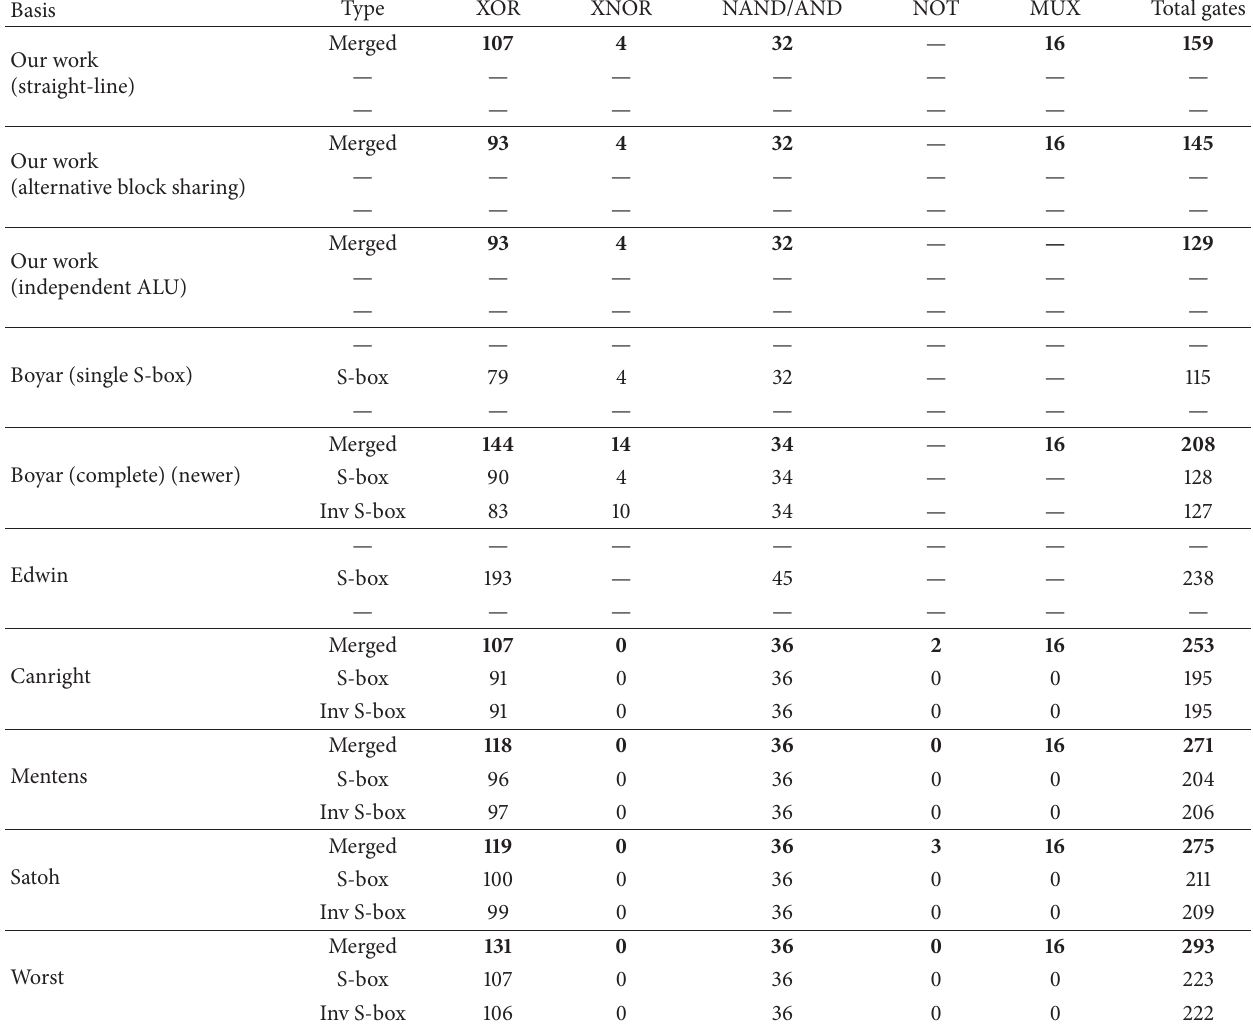
Table 5: The comparison of different